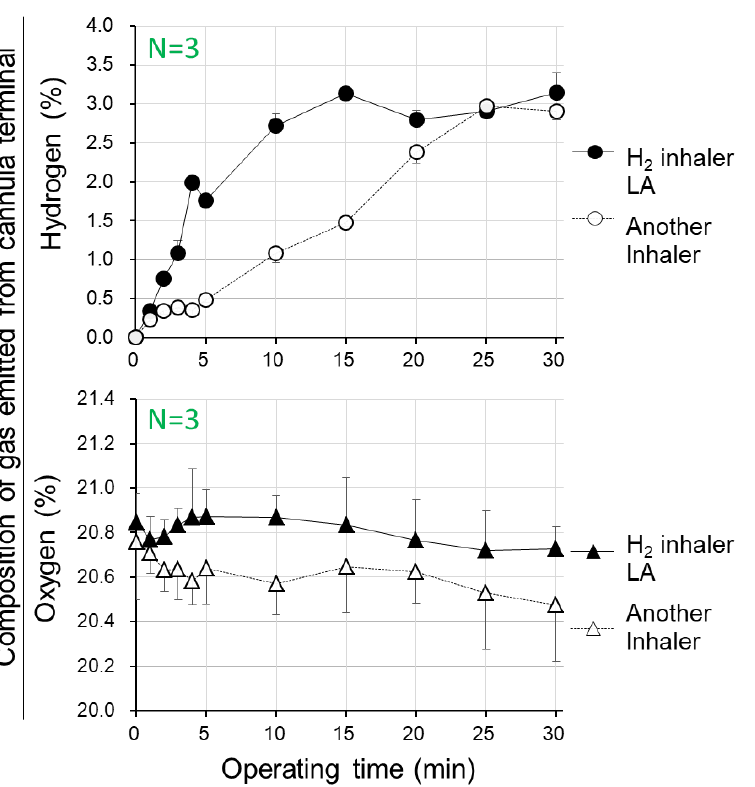
Figure 1. Time courses of concentrations of hydrogen and oxygen in gas which were emitted from the cannula terminal during operation of hydrogen gas inhalation apparatus. Two types of hydrogen gas inhalers, the proton exchange membrane (PEM)-/Pt-plated electrode-based, electrolysis-generated hydrogen gas inhaler LitaAir (H 2 inhaler LA) and another device model, were operated for 30 min, and the concentrations of hydrogen and oxygen in the cannula terminal for gas inspiratory usage were measured. Mean ± SD, n = 3.